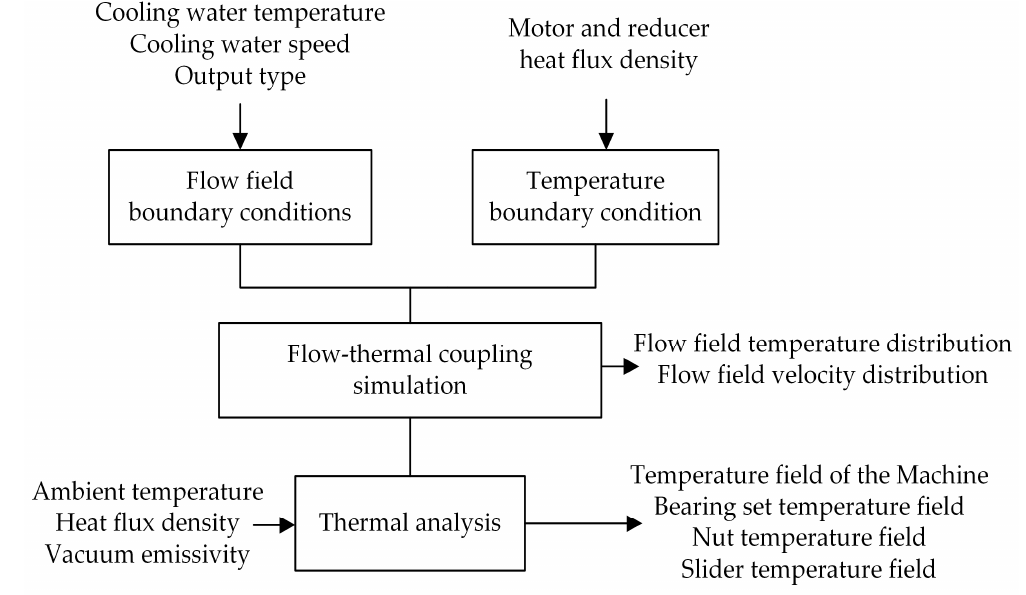
Figure 3. Simulation flow chart.